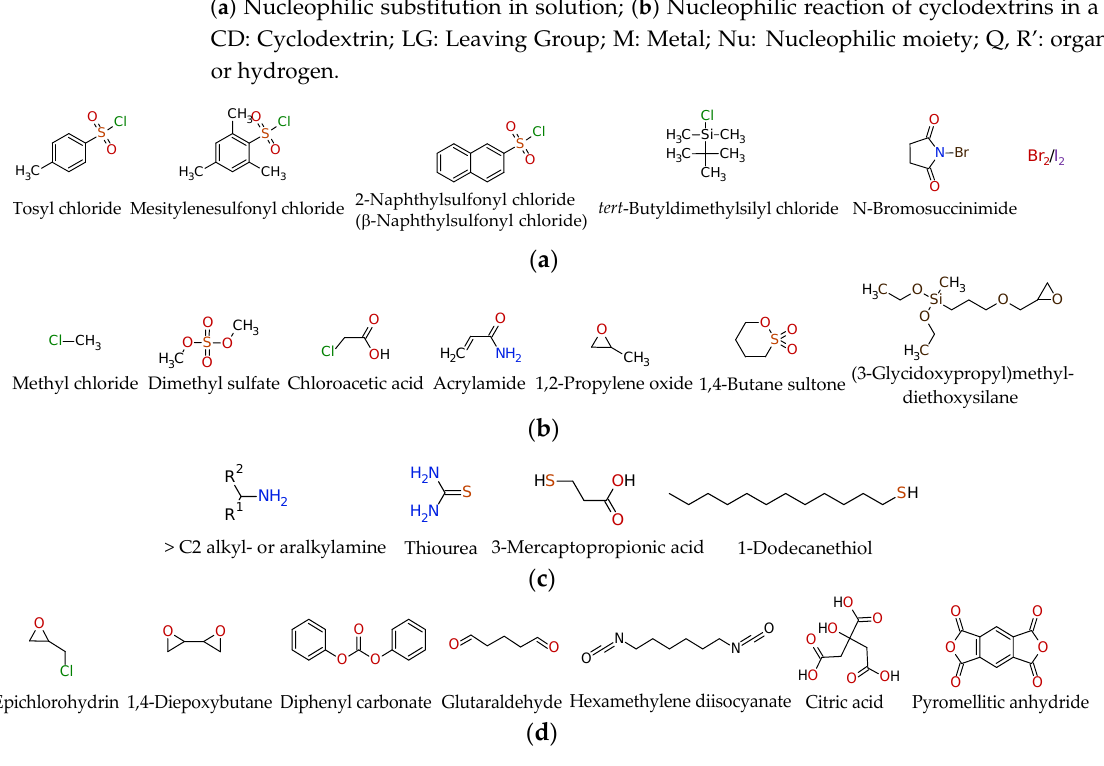
Figure 3. The most common reagents used in CD syntheses. ( a ) Reagents for regioselective mono- or oligosubstitutions; ( b ) Reagents used in random substitutions; ( c ) Reagents for regioselective persubstituted CDs; ( d ) Crosslinking reagents used for CD polymerization.